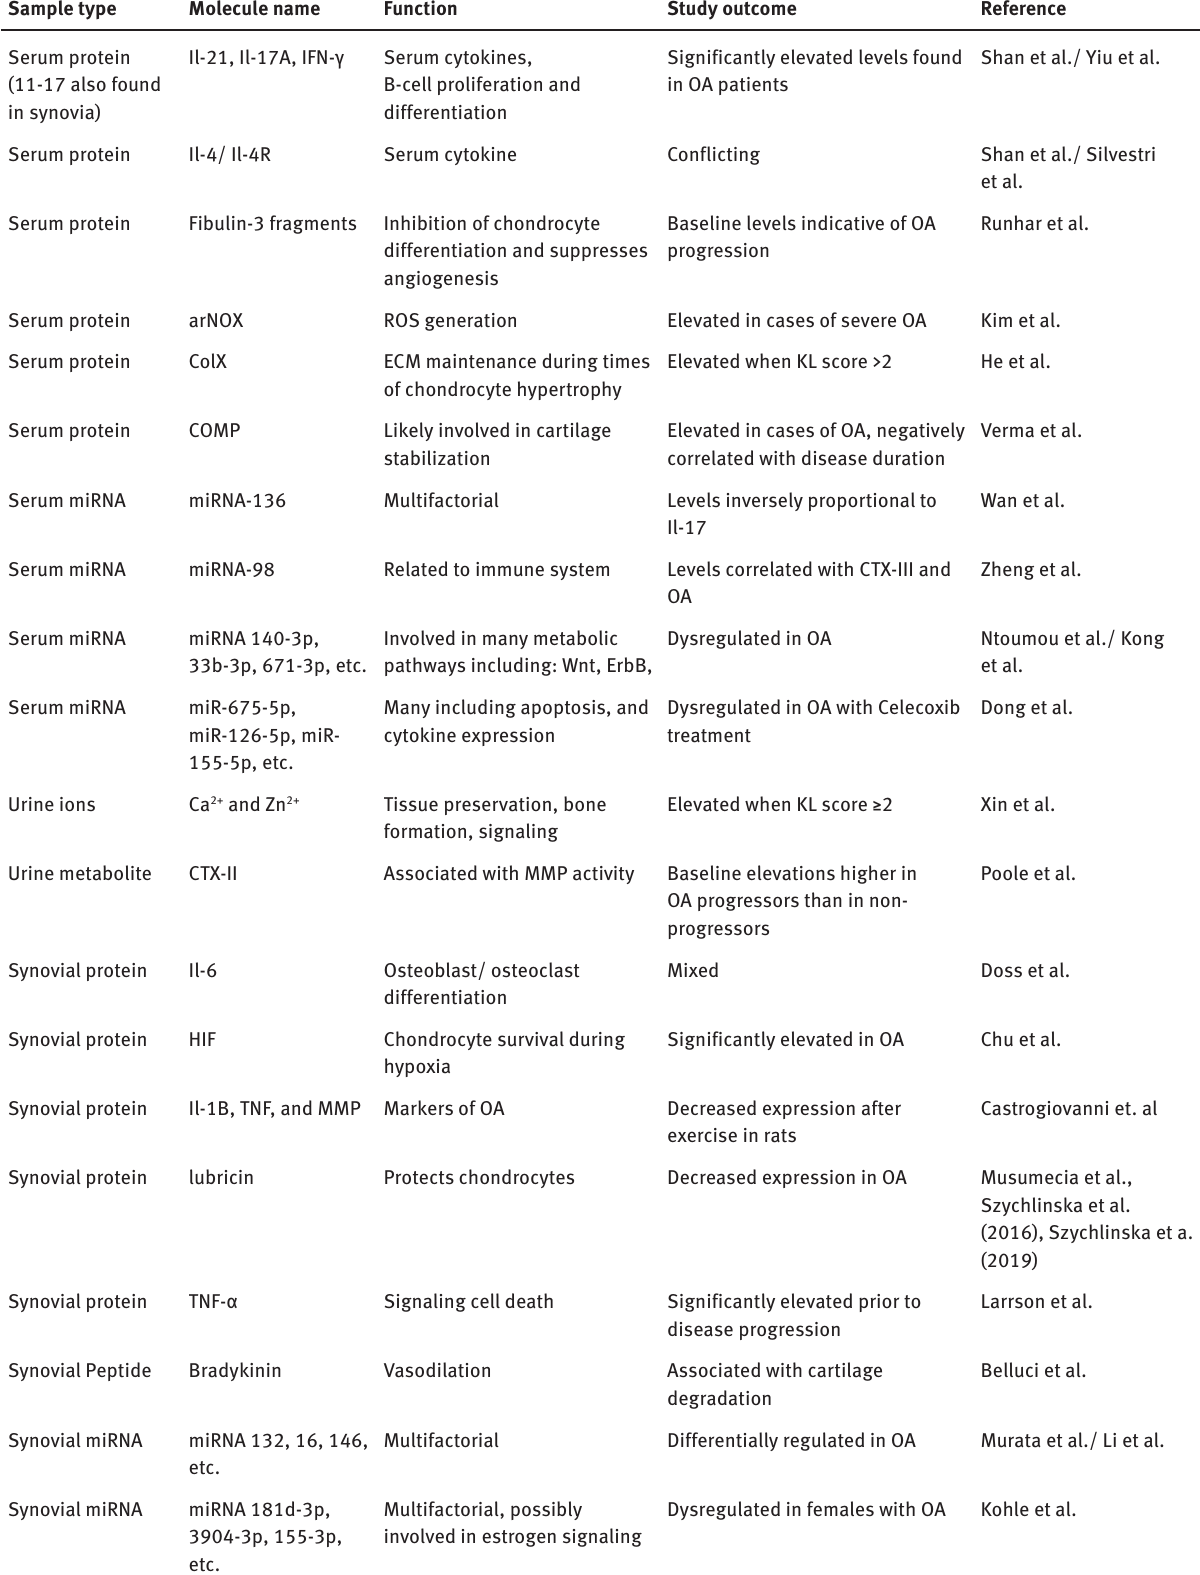
Table 1: Molecular biomarkers and their role in pathophysiological function of osteoarthritis. Sample